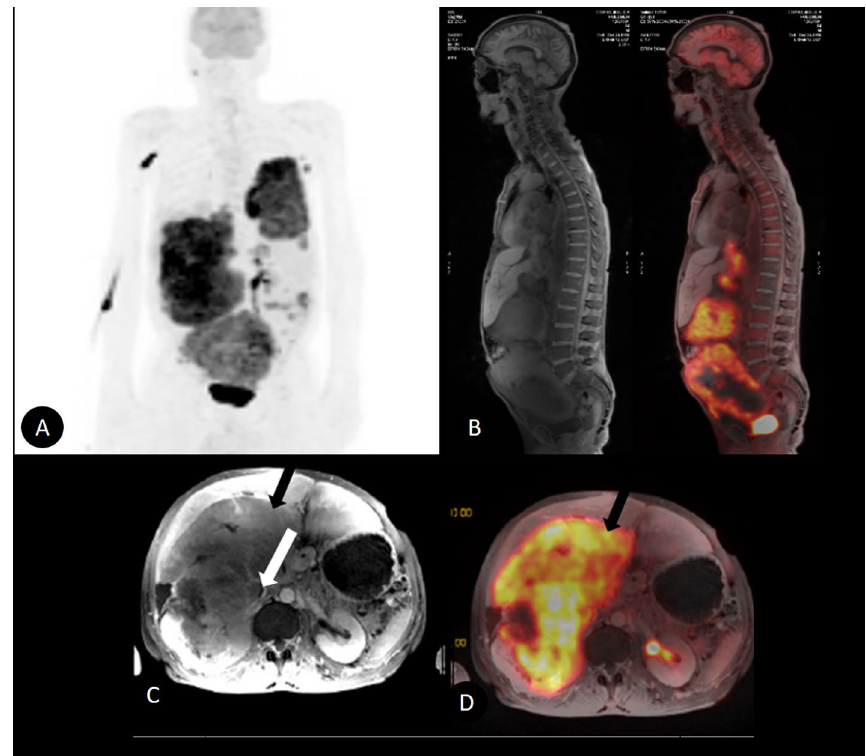
in the retroperitoneum and abdominal cavity. PET/MRI sagittal fusion images B illustrate the extension and compromise of distant organs. PET/MRI axial images C , D demonstrate the origin of the tumor from IVC (white arrow) with an eccentric